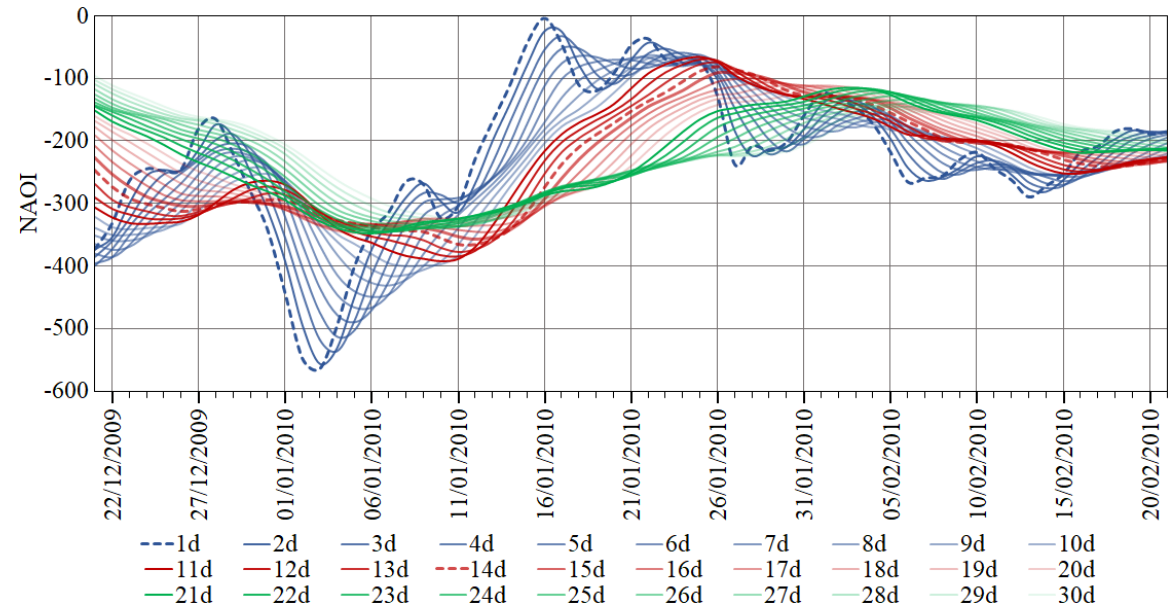
Figure 3. Example of the non-smoothed (1d) and smoothed daily NAOI series in a period prior to the 20 February 2010 flash floods, landslides and debris. The smoothed NAOI values were computed by a low-pass filter, or moving average, from the previous 2 days (2d, m = 2) to previous 30 days (30d, m = 30) and assigned to the most recent record date.